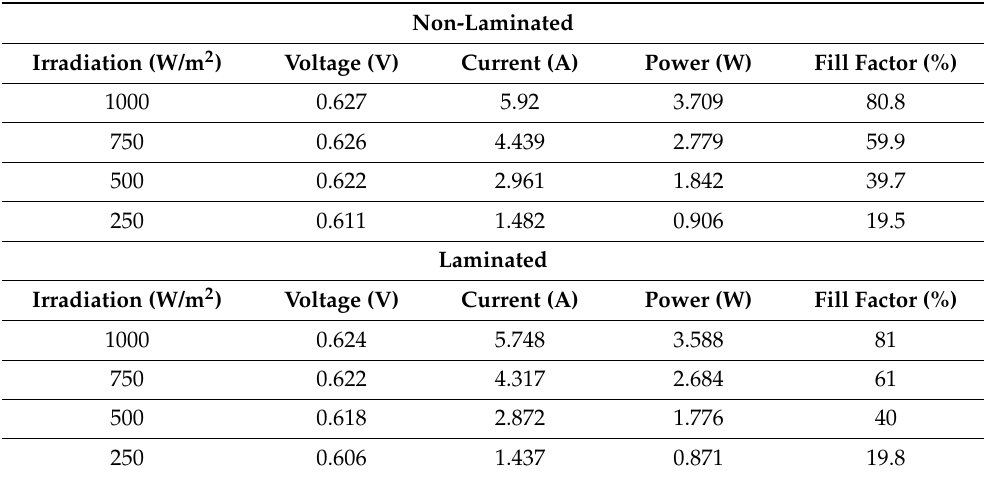
Table 5. MPPT data of tested solar